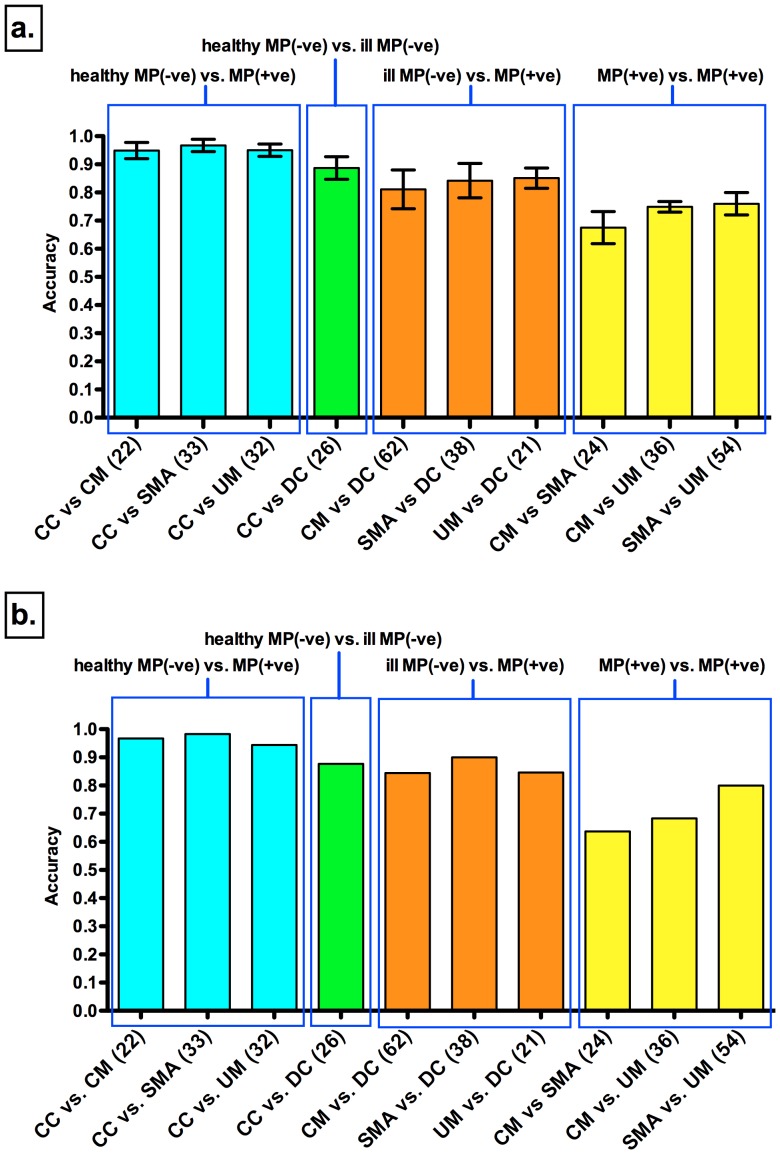
Discriminatory accuracy of proteome profiles across study groups.CM = Cerebral Malaria; SMA = Severe Malarial Anemia; UM = Uncomplicated Malaria; DC = Disease Controls; CC = Community Controls. Blue bars compare (CM, SMA and UM) with non-parasitemic CC. MP(−ve) = malaria parasite negative; MP(+ve) = malaria parasite positive. Green bar compares DC and CC (both non-parasitemic). Orange bars compare (CM, SMA and UM) with DC (non-parasitemic). Yellow bars compare CM, SMA and UM (all parasitemic) among themselves. In brackets are shown the number of relevant m/z clusters that make up the discriminatory proteome profile. (a.) Accuracy of predictive models built with relevant m/z clusters using the discovery cohort data. Error bars indicate +/− standard deviations obtained by 100 train/test randomizations of the data. (b.) Accuracy of the best predictive model from (a.) when applied to the validation cohort data.